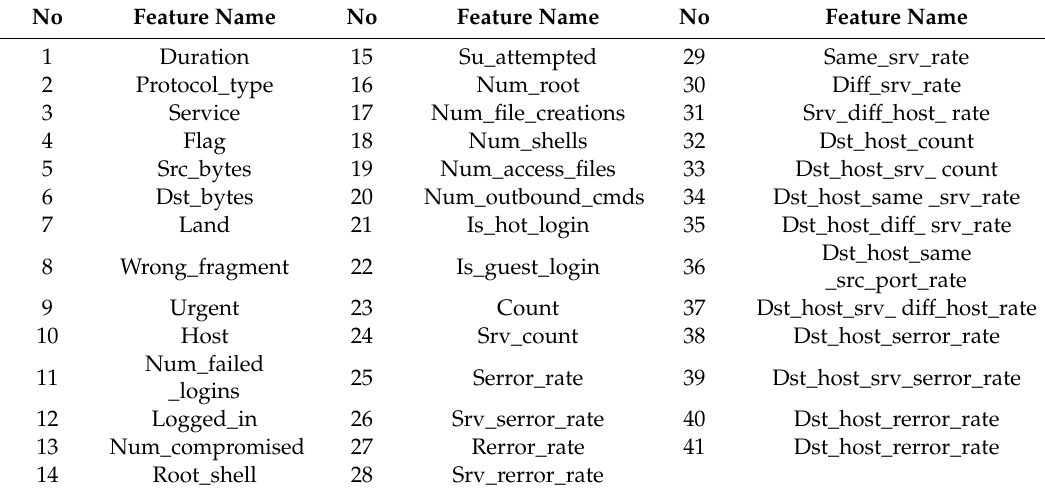
Table 1. List of features in the NSL-KDD and KDD Cup 99 dataset.